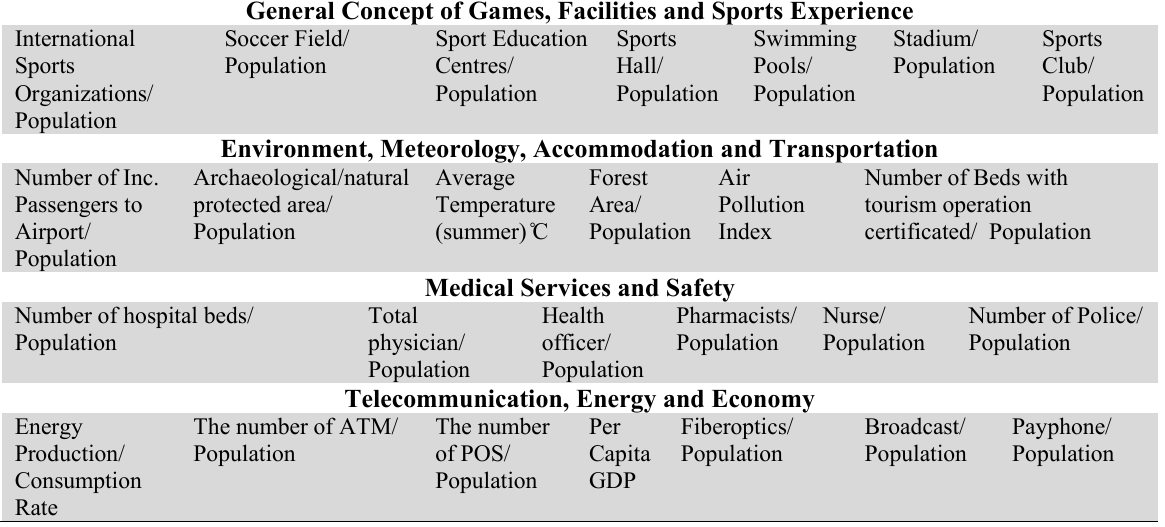
Main and Sub Criteria Used in Analysis General Concept of Games, Facilities and Sports